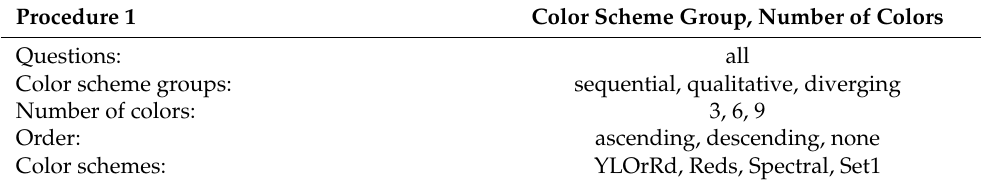
Table 3. Header of the first procedure.